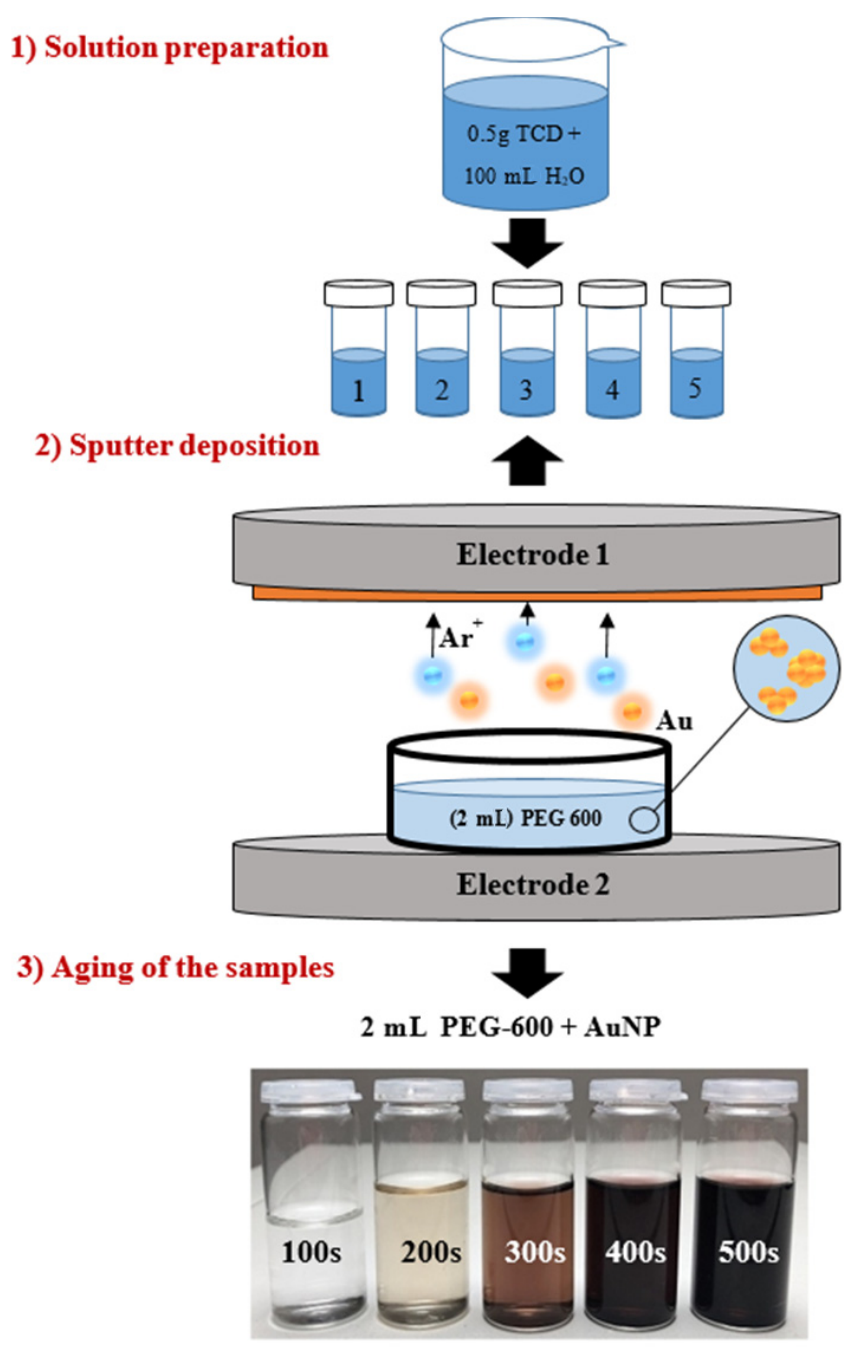
Figure 1. Principle of the preparation of a series of AuNPs solutions for one concentration of TCD ( c = 17.0 mmol · L − 1 ): ( 1 ) preparation of the TCD solution and subsequent dosing of 18 mL into glass sample containers; ( 2 ) deposition of AuNPs into 2 mL PEG-600 at selected times (100–500 s), followed by the addition of TCD; ( 3 ) after aging of the products.